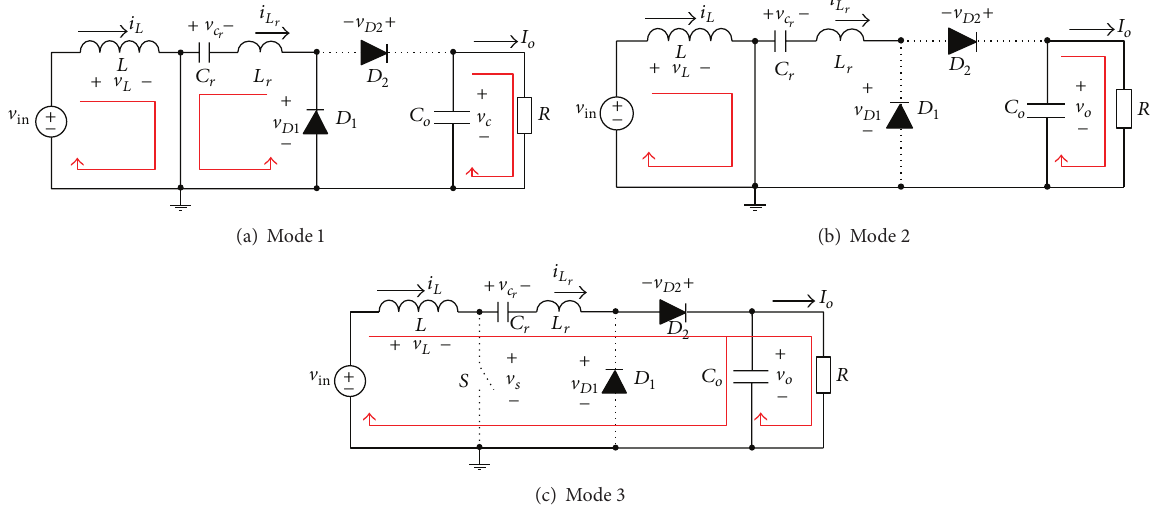
Figure 2: Equivalent circuit of operation mode of the converter with positive input voltage.